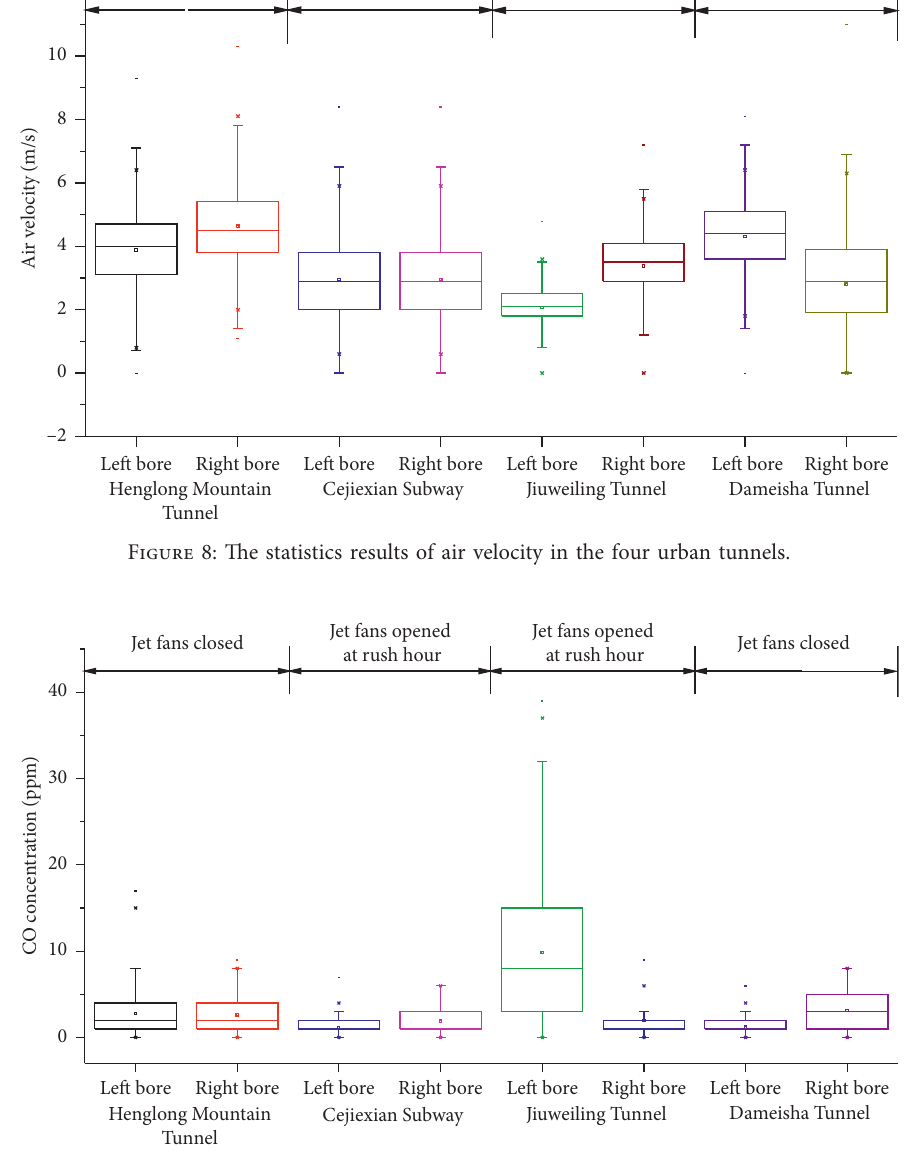
Figure 9: The statistics results of CO concentration in the four urban